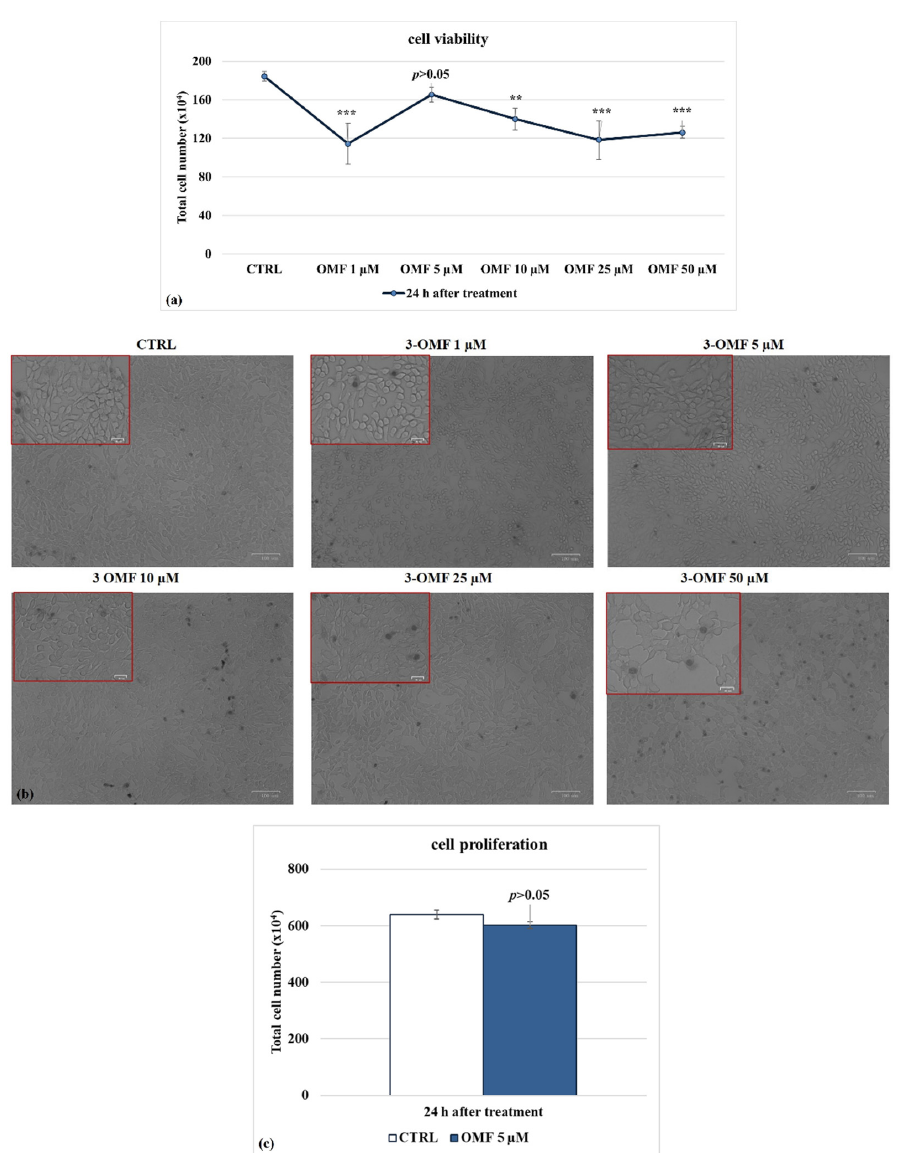
Figure 2. Identifying IC 50 of OMF at different doses and developing dose–response curve in MDBK cells. ( a ) Dose–response curve of MDBK cells treated with OMF at different concentrations (1, 5, 10, 25, and 50 µM). At 24 h after treatment, cells were stained with TB and scored by automated cell counter, or ( b ) cell viability was determined by TB staining while cells were attached to wells and counted under a light microscope. ( c ) Dose–response curve of MDBK cells treated with OMF (5 µM) for 24 h and assessed by MTT assay. Significant differences between control and OMF-treated cells are indicated by probability p . ** p < 0.01 and *** p < 0.001. Scale bar 100 µm.